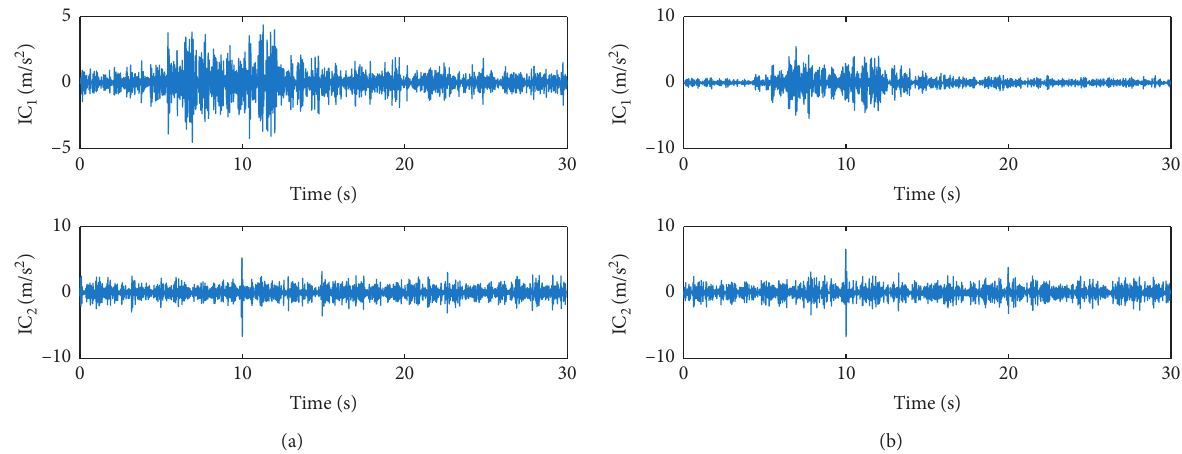
Figure 15: Independent component of the simulated structure under Kobe earthquake wave. (a) Case 1. (b) Case 2.